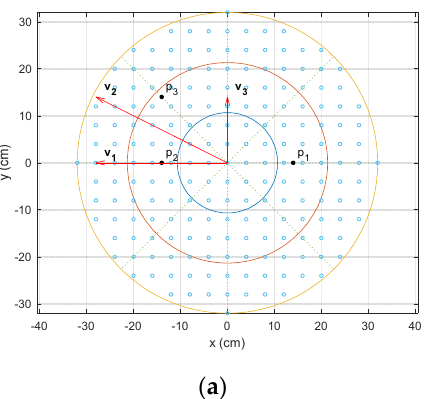
) show the vectors 1 , v 2 , v 3